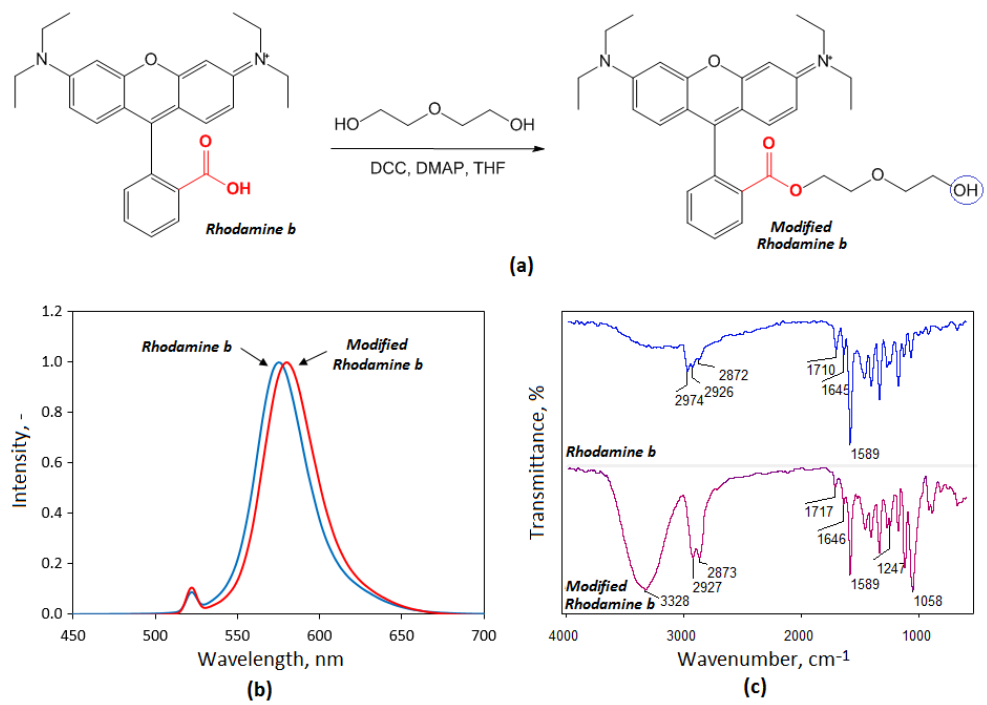
Figure 1. ( a ) Rhodamine b modification pathway; ( b ) fluorescence spectra of the rhodamine b and modified rhodamine; ( c ) FTIR of the rhodamine b and its derivative, N -(9-(2-carboxyphenyl)-6- (diethylamino)-3 H -xanthen-3-ylidene)- N -ethylethanaminium (Rhod-OH).